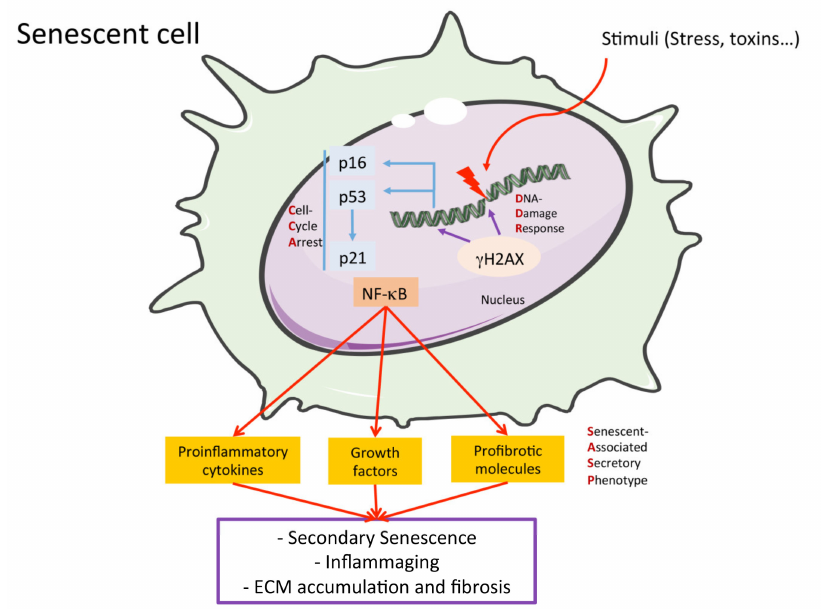
Figure 2. Principal hallmarks of senescent cells. Many different stimuli may cause a DNA damage in the cell and activate the DNA-Damage Response (DDR), which may produce the expression of the Cell-Cycle Arrest (CCA) molecules. Prolonged activation of DDR and CCA proteins produce cellular senescence and the release of the Senescent-Associated Secretory Phenotype (SASP), enriched in different proinflammatory, profibrotic and growth factors that are regulated by NF- κ B pathway activation and may cause activation of cellular senescence in a paracrine manner, inflammaging and fibrosis in the kidney, and other